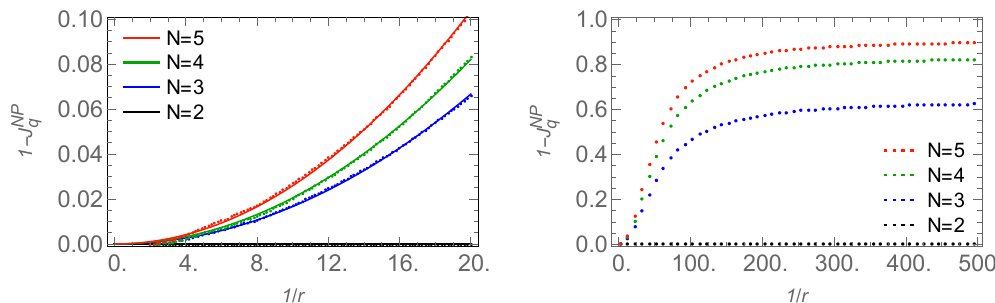
Figure 4 . The nonperturbative corrections 1 (cid:0) J NP to the semi-inclusive quark jet function for q Mellin moments N = 2 (black), 3 (blue), 4 (green), 5 (red) as function of 1 =r . The points were extracted from parton-level and hadron-level Pythia data, using e + e (cid:0) collisions at a center-of- mass energy of ! = 500 GeV, with the e + e (cid:0) anti-k T algorithm. In the left panel we restrict to large values of r and show a (cid:12)t to c=r 2 (solid lines). In the right panel, the asymptotic approach to the fragmentation limit is shown. The nonperturbative corrections for N = 2 vanish due to eq.